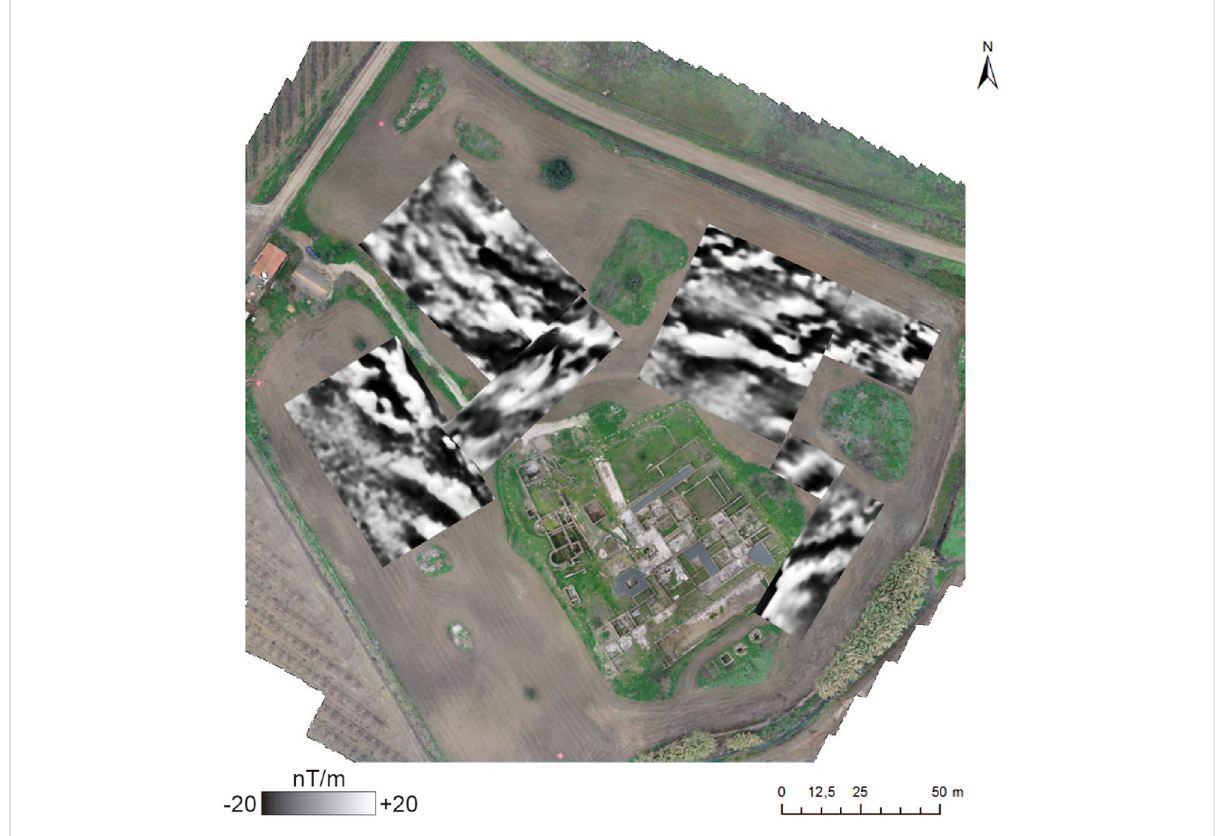
FIGURE 5 Results ofverticalgradientmagneticsurveyscarried outinthesevenprospectedstudy areas.All datasetswere fi lteredwith identical sequences of operations, adapted to each dataset, with the additional application of reduction to the magnetic pole.